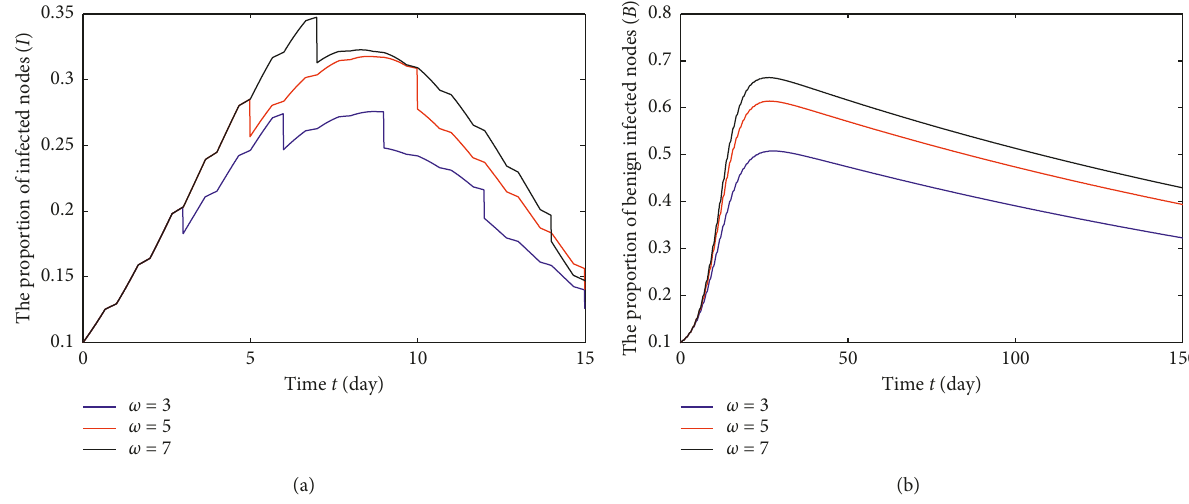
Figure 4: Evolution of I ( t ) and B ( t ) of system (5) for the different values of quarantine time ω .